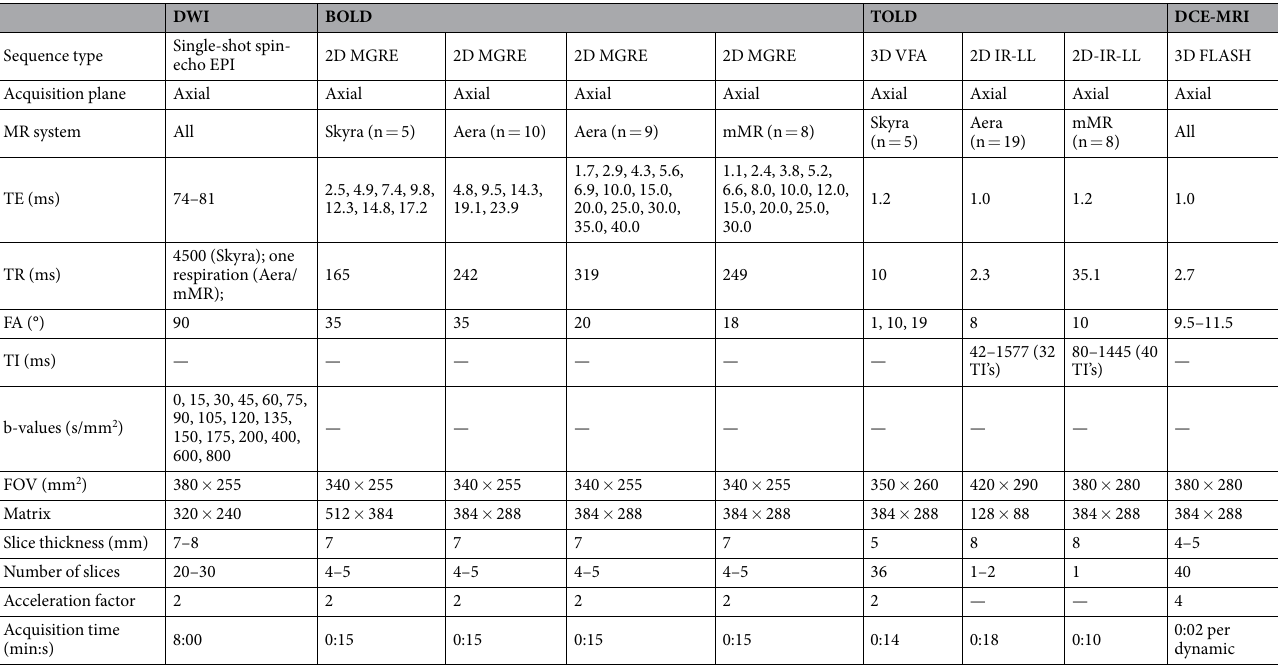
Table 1. Acquisition parameters of the multiparametric MRI protocol. EPI = echo planar